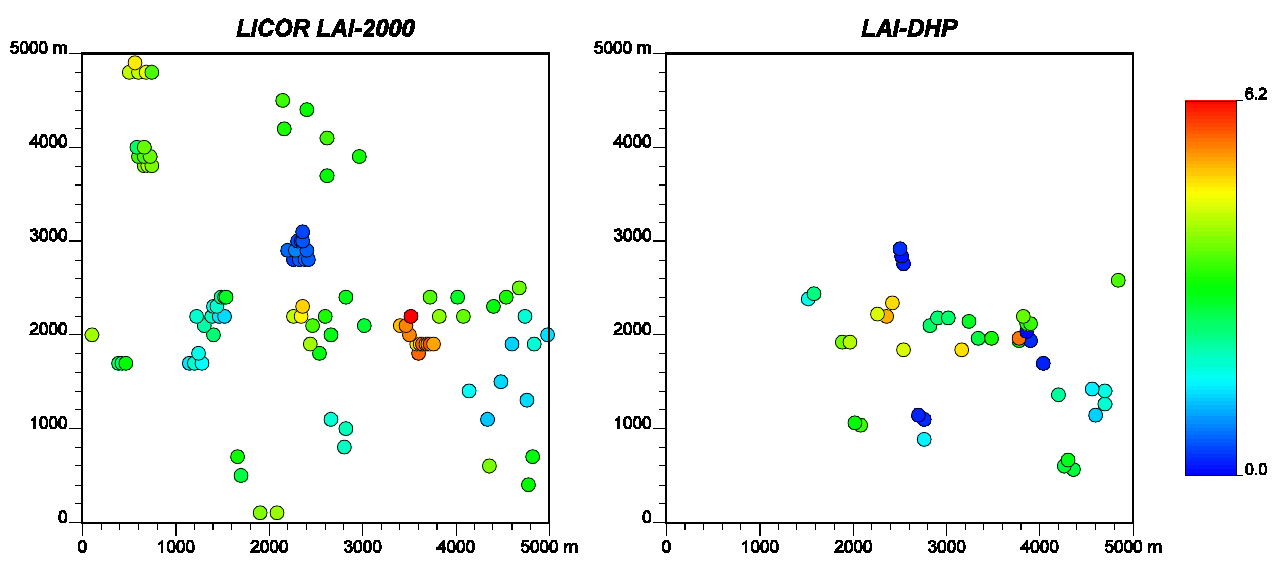
Figure 3. Elementary sampling units (ESUs) acquired with the LICOR LAI-2000 (left) and the hemispherical camera (right). The LAI estimates from the hemispherical camera are assumed to be a suitable validation set of the OK, CKC and KED